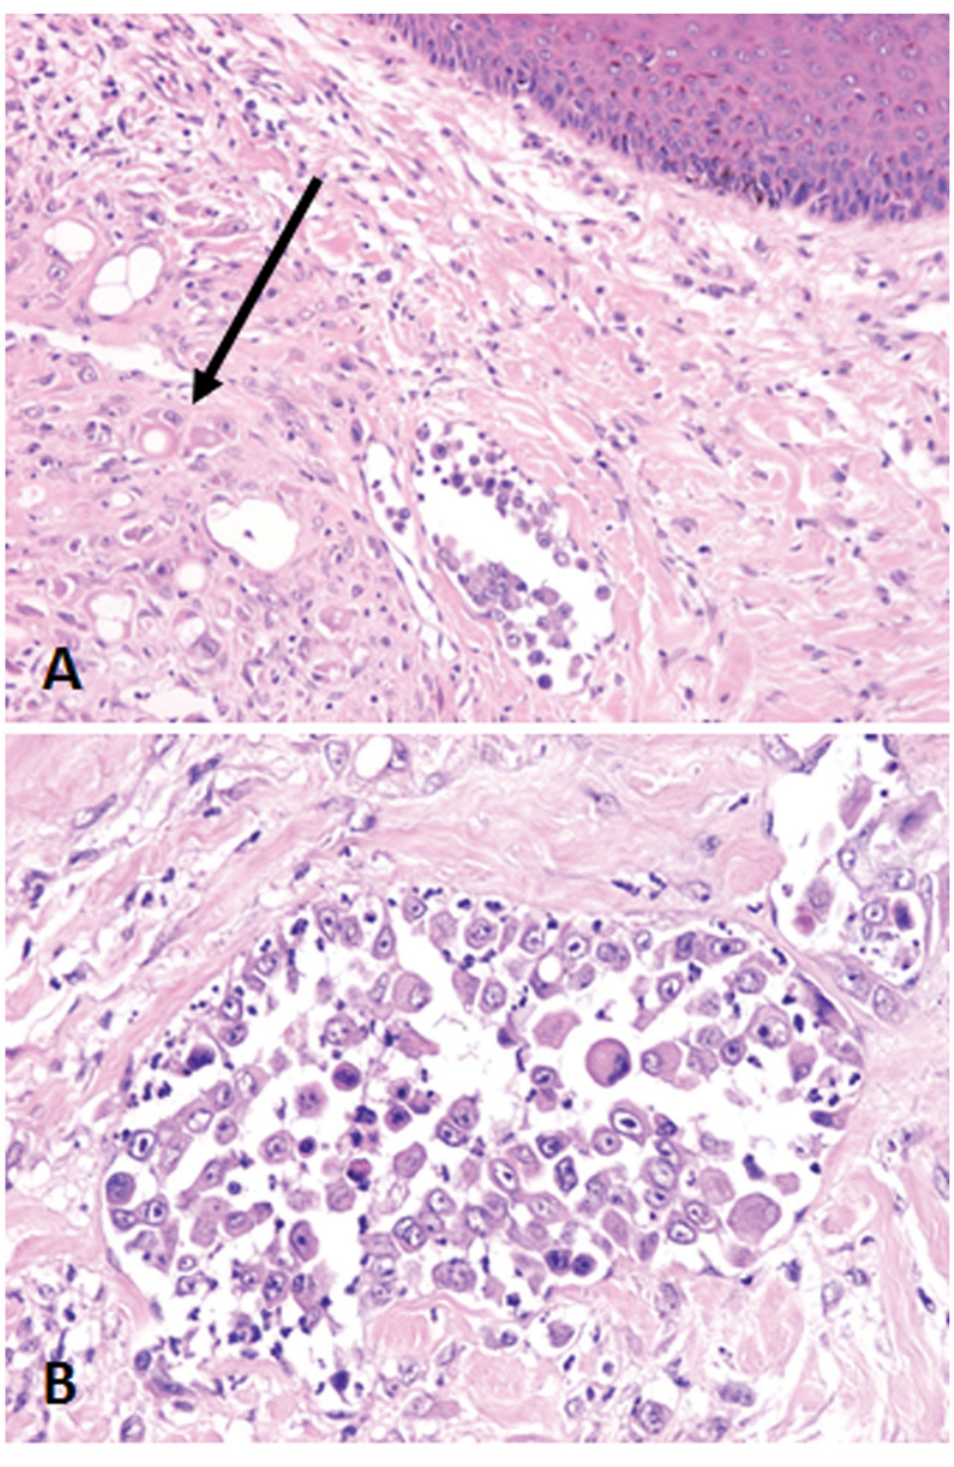
Fig 1. Primary canine inflammatory mammary carcinoma origin of the cell line IPC-366. Tumor paraffin sections, H&E. A (10X) y B (20X). Neoplastic emboli in superficial dermis. Tumor cells exhibit marked anisocitosis and anisokaryosis, and evident large nucleoli. Infiltrating tumor cells (arrow).